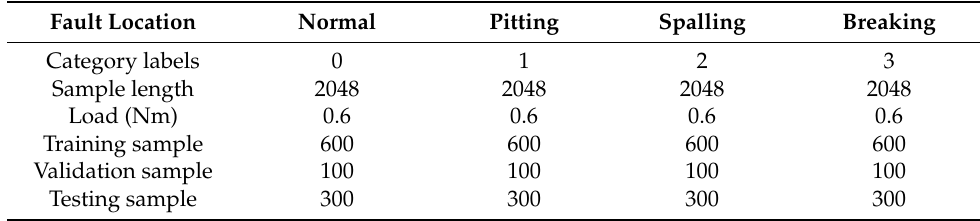
Figure 13. Worm gear fault test rig. Table 3. Description of the worm gear dataset and sample